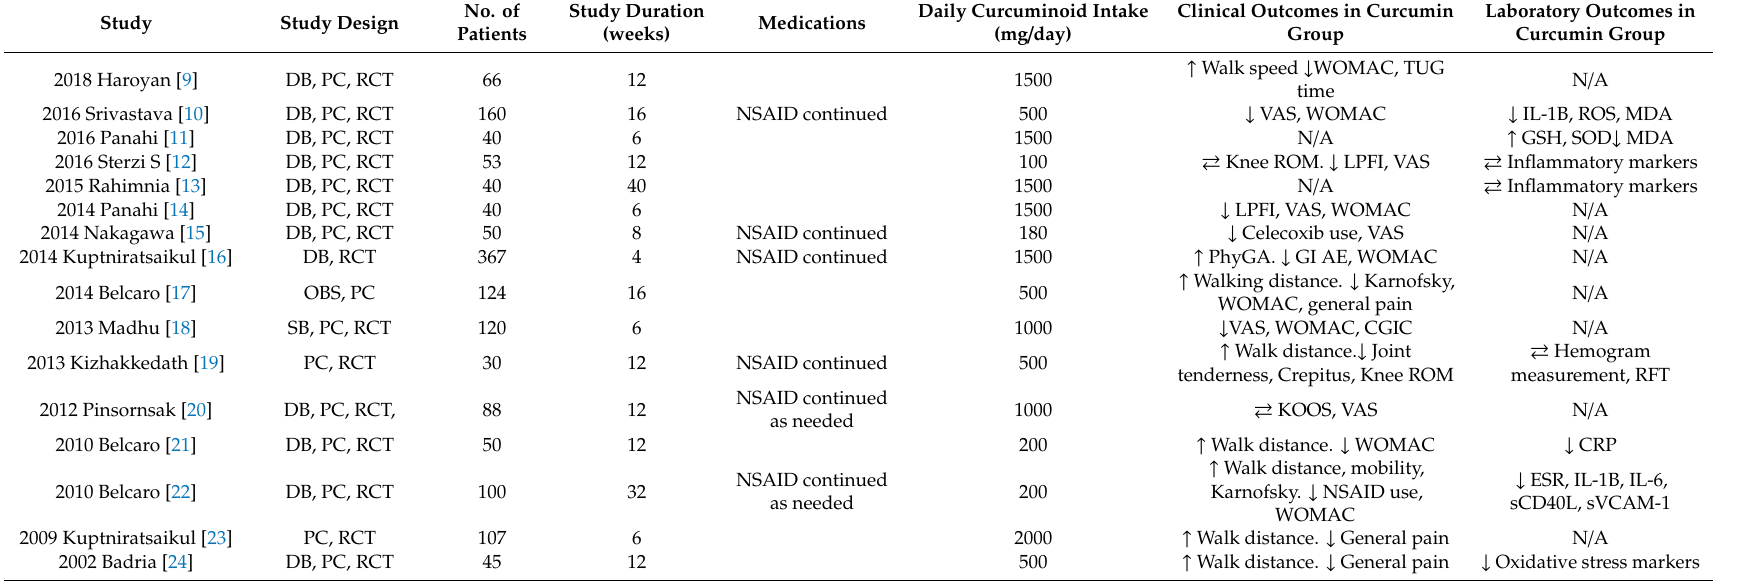
Table 1. Clinical e ffi cacy of curcumin supplementation in osteoarthritis